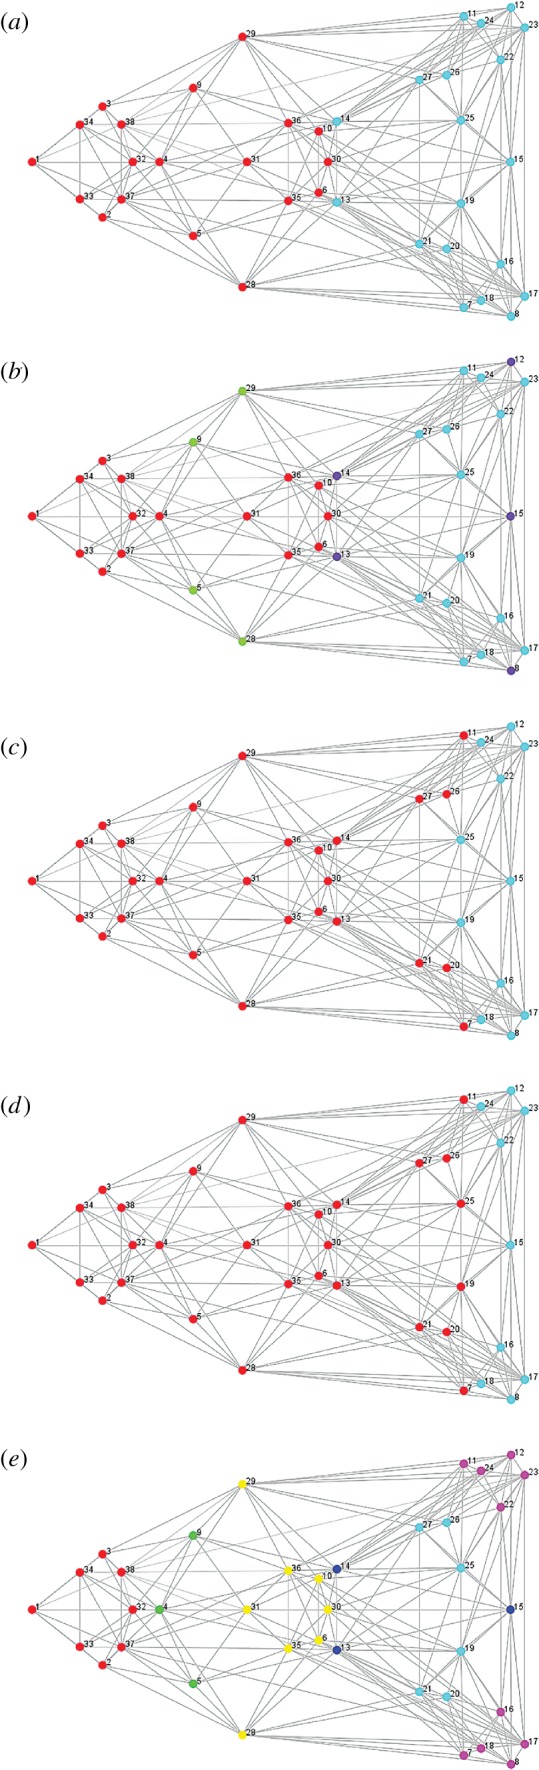
Hypothesized modularity models with numbers of modules varying from two to six. Models: (a) face and neurocranium model; (b) functional groups model (four modules: oral–nasal, orbital, vault and basicranial); (c) tissue origin (two modules: neural crest and paraxial mesoderm); (d) ossification mode model (two modules: dermal and endochondral) and (e) the six-cluster model (six modules: oral, nasal–orbital, molar–zygomatic, vault, pterygoid and basicranial regions).